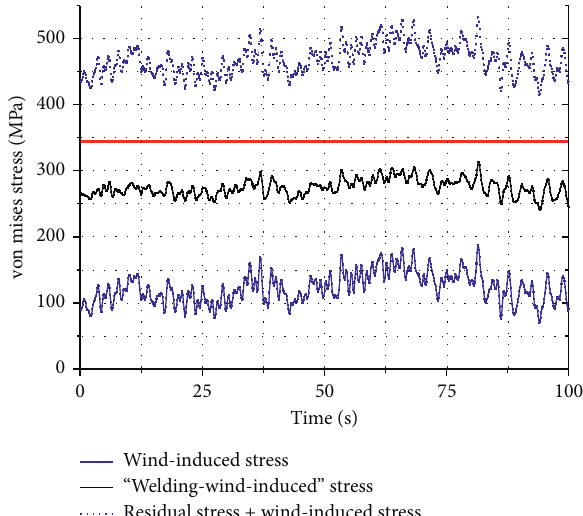
Figure 13: Comparison of stress time history at the fatigue critical